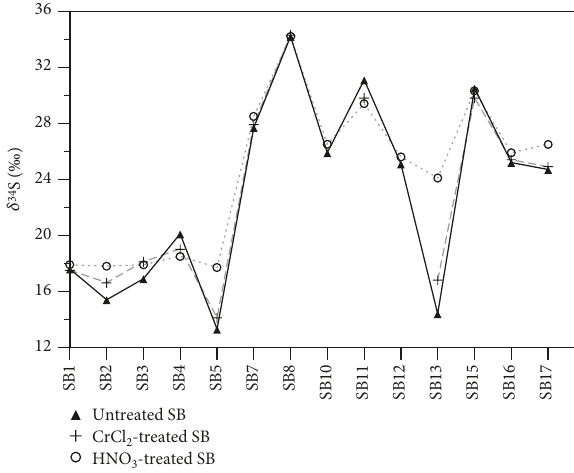
Figure 7: Variations in the sulfur isotopes of the untreated, CrCl -treated, and HNO -treated solid bitumen (SB) 2 3